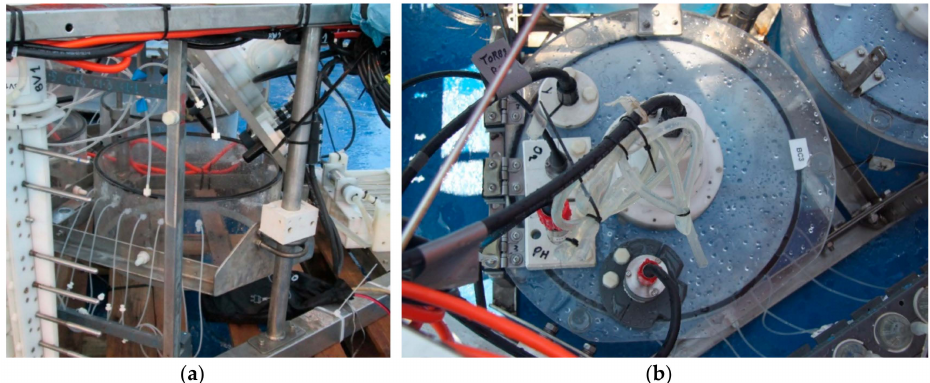
Figure 9. Amerigo Lander. ( a ) Lateral view of a benthic chamber mounted on the chassis with the top lid open, the tubes on the lateral wall to collect water samples, and the rotating paddle. ( b ) Top view of a benthic chamber with the closed top lid fitted with the oxygen, pH, methane, and turbidity sensor.